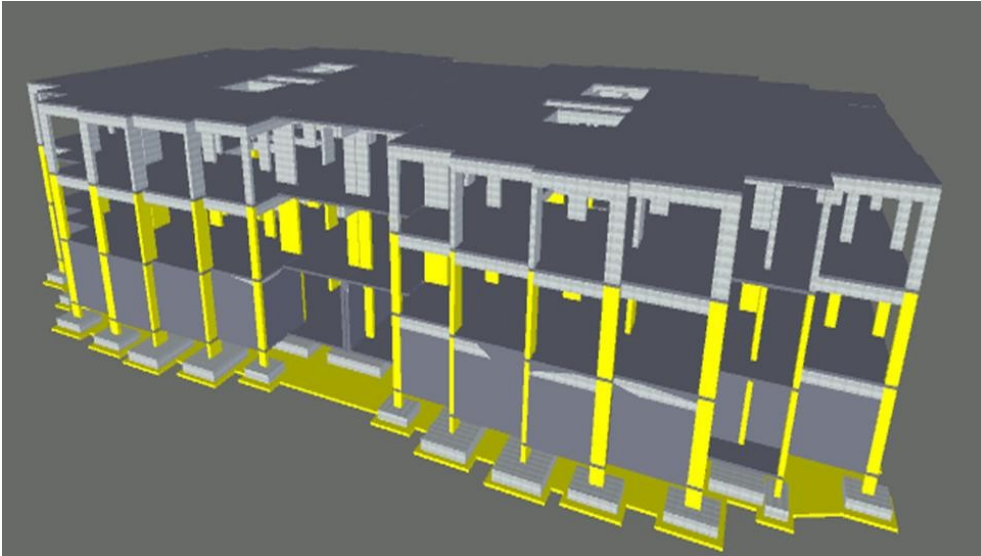
Figure 14. Activities with a DEI of less than 0.80 appeared in yellow during the simulation.